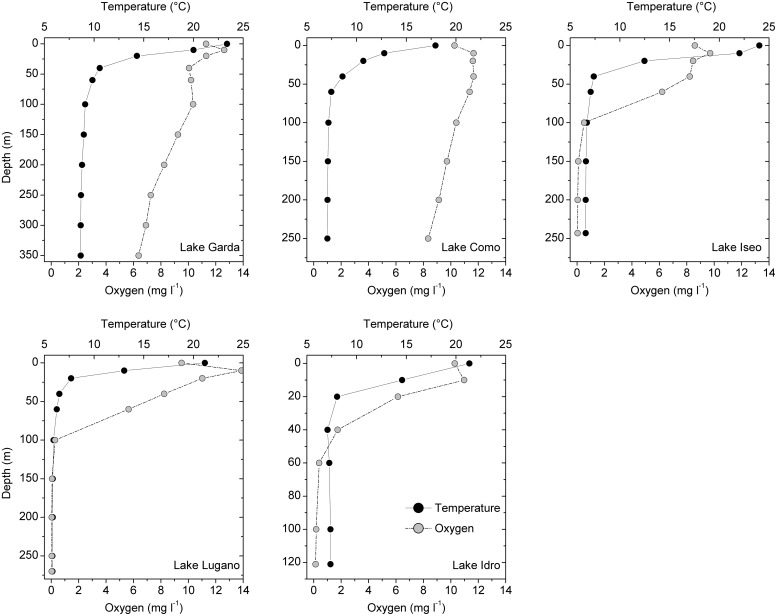
Vertical measurements of water temperatures and oxygen concentrations in the two oligomictic (Garda and Como) and three meromictic (Iseo, Lugano, and Idro) lakes at discrete depths. Vertical scales are identical in lakes Como, Iseo, and Lugano. Samples for the determination of other chemical compounds and for HTS analyses were collected at the same depths.